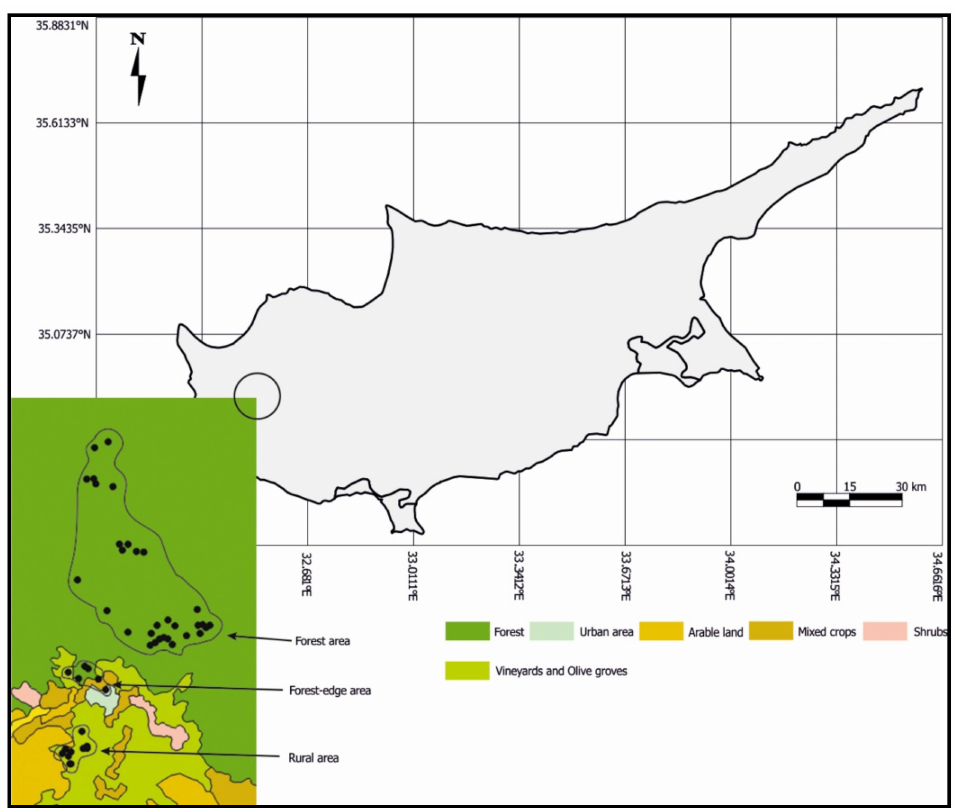
Figure 1. Map showing the location of Paphos Forest (circle) on the Island of Cyprus and the locations of the nest boxes in the rural, forest-edge, and forested